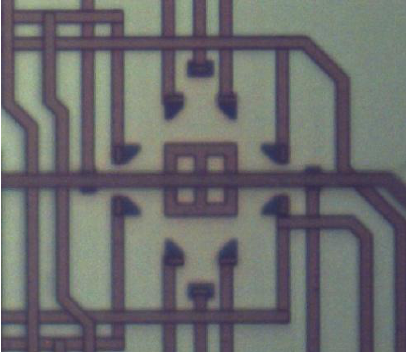
Figure 8. Optical image of the magnetic sensor after the CMOS process.